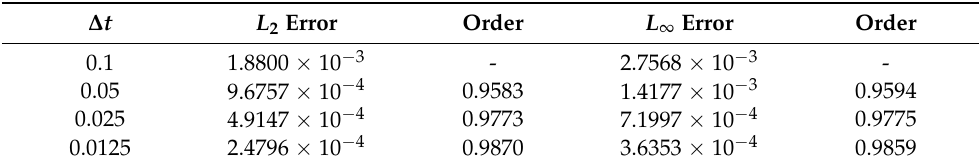
Table 2. The truncation error and convergence order of temperature T with ∆ y = 0.01.